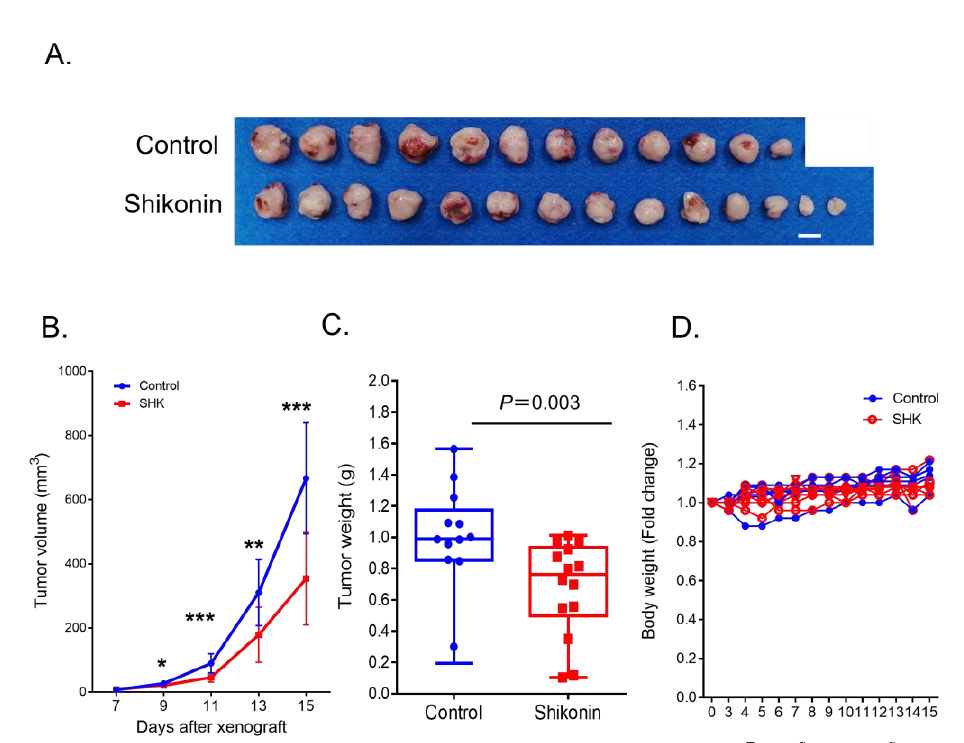
Figure 6. SHK inhibited ATLL cell growth in vivo. ED − cells were subcutaneously injected into both flanks of BALB/c RJ mice. SHK 10 mg/kg was administered by oral gavage twice daily for 15 consecutive days. Tumor was allowed to develop for three days before starting treatment. Control mice were injected with DMSO. ( A, B ) Tumor growth was monitored by measuring maximal and minimal diameters with calipers every other day, and tumor size was estimated with the formula: tumor size mm 3 = length (mm) × width 2 (mm) × 0.4, as described previously [23,24]. *p<0.05, **p<0.01, ***p<0.001 . ( C ) Tumor weight was measured at the end of the experiment. Data are shown as box-and whisker plot. Each dot represents the weight of a single mass. ( D ) Body weight was measured daily.